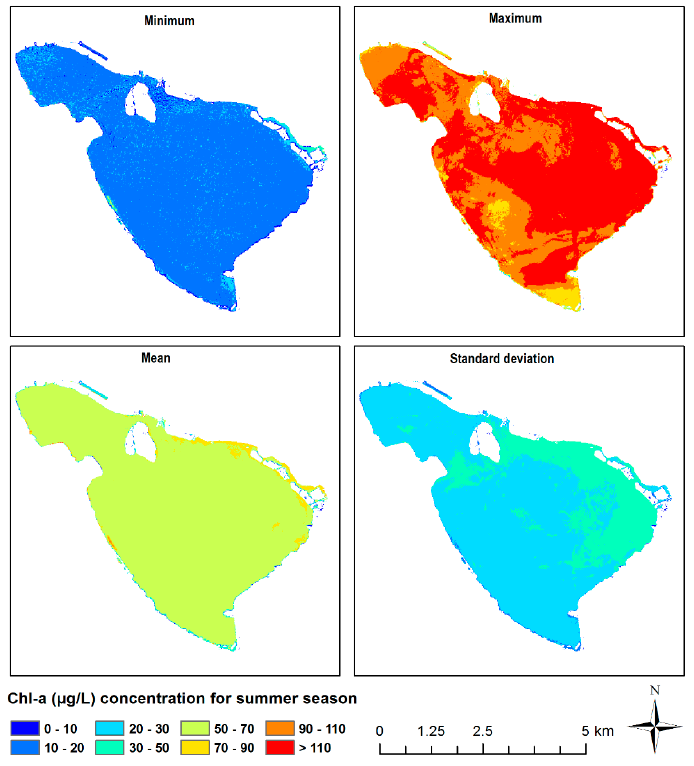
Figure A7. Chl- a concentration for a summer season.